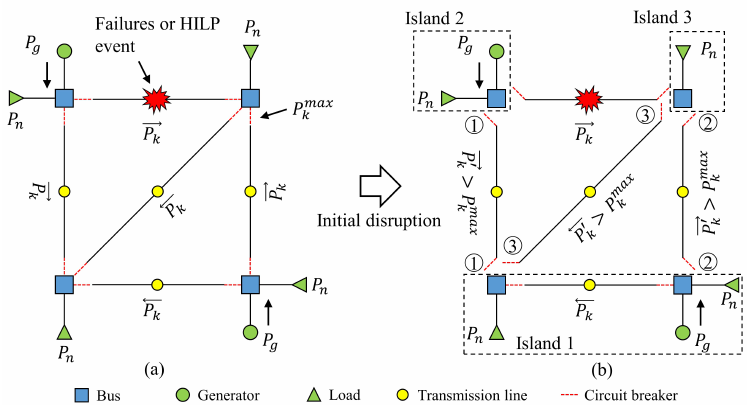
Figure 2. Initial interruption. Operation of power line circuit breakers: ( a ) initial state; and ( b ) first interruption